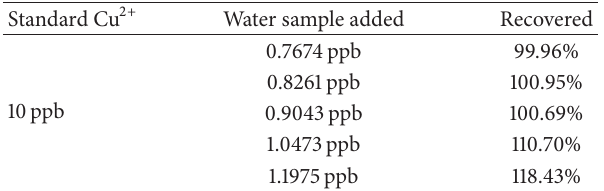
Table 3: Recovery test for Cu 2+ in sample of drinking water. Standard Cu 2+ Water sample added Recovered 0.7674 ppb 99.96% 0.8261 ppb 100.95% 10ppb 0.9043 ppb 100.69% 1.0473 ppb 110.70% 1.1975 ppb